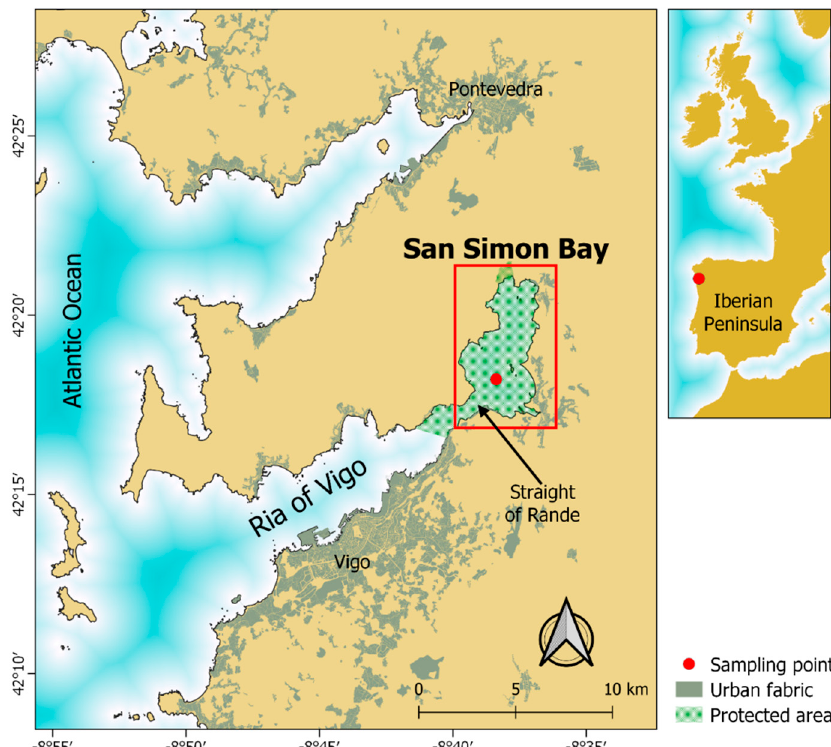
Figure 1. Location of San Simon Bay in the Ria of Vigo (NW Iberian Peninsula) and the position of the sampling point. Map elaborated with QGIS 3.4 with layers from the Spanish National Geographic Institute ( © IGN) and the Directorate General of Nature Conservation of the Ministry of the Environment, Territory and Infrastructures s ( © Xunta de Galicia).